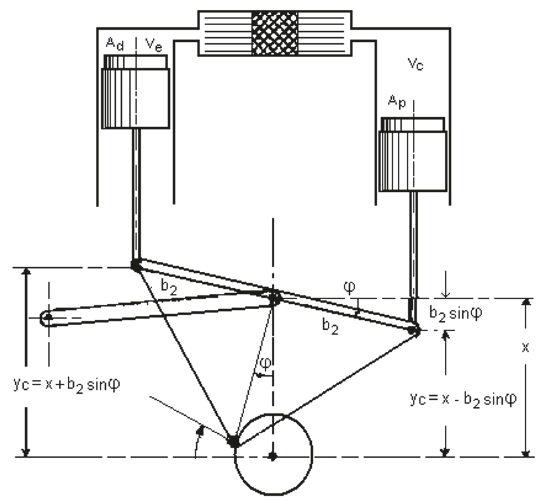
Figure 6: Yoke Ross Stirling engine